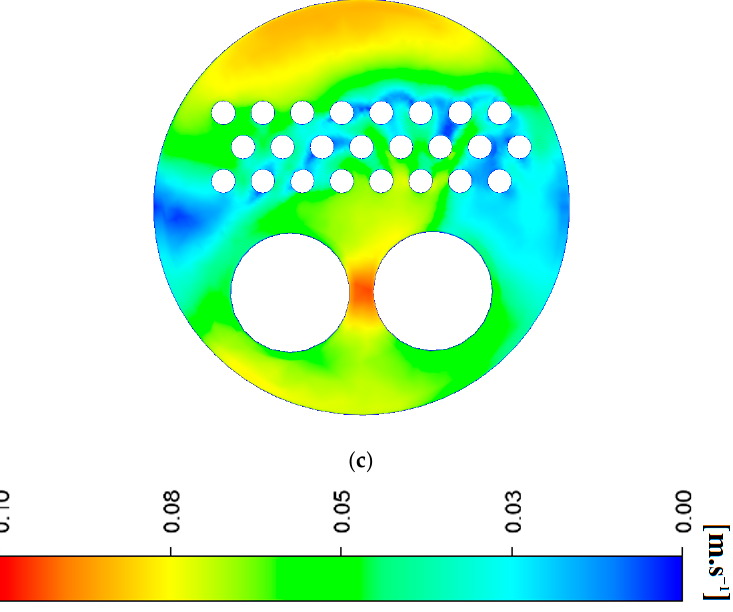
Figure 9. The distribution of velocity magnitude in the various slices inside the shell: ( a ) Slice 1, ( b ) Slice 2, ( c ) and Slice 3.